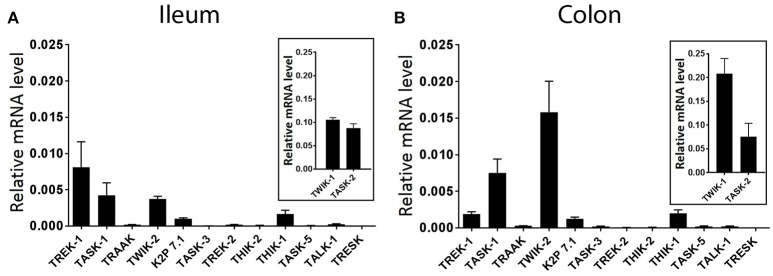
Differential expression of K2P subtype transcripts in the mouse ileum and colon. Quantitative, real-time PCR performed on lysates of acutely isolated ileum (A) and colon (B) from wild type mice. Data are expressed as relative mRNA levels (2−ΔCt) compared to the housekeeping gene GAPDH (mean ± SEM, n = 3). TWIK-1, (KCNK1), and TASK-2 (KCNK5) displayed the highest relative expression levels in both ileum and colon (insets). Rank order of detectable expression was as follows, in ileum; TWIK-1 (KCNK1) > TASK-2 (KCNK5) > TREK-1 (KCNK2) > TASK-1 (KCNK3) > TWIK-2 (KCNK6) > THIK-1 (KCNK13) > K2P 7.1 (KCNK7), and in colon; TWIK-1 (KCNK1) > TASK-2 (KCNK5) > TWIK-2 (KCNK6) > TASK-1 (KCNK3) > TREK-1 (KCNK2) > THIK-1 (KCNK13) > K2P 7.1 (KCNK7).